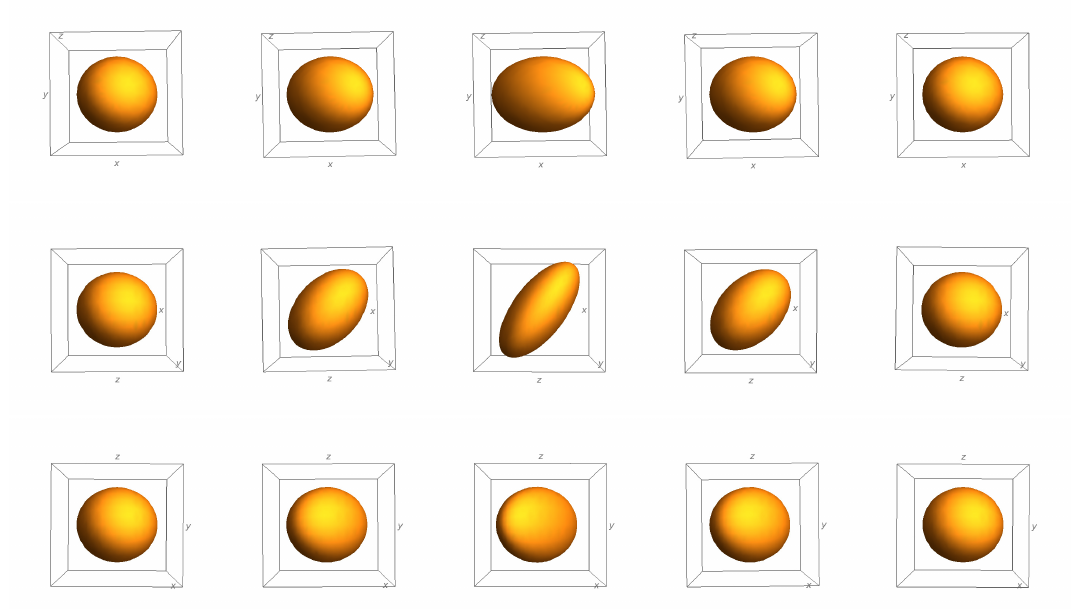
Figure 1. The distortions of a sphere during a full oscillation period due to the presence of the x − z transverse mode viewed from different perspectives. From top to bottom, the three rows correspond the distortion projected onto the x − y , x − z , and z − y planes, respectively. From left to right, the columns represent the results at the instants 0,1/4,1/2,3/4,1 of an oscillation